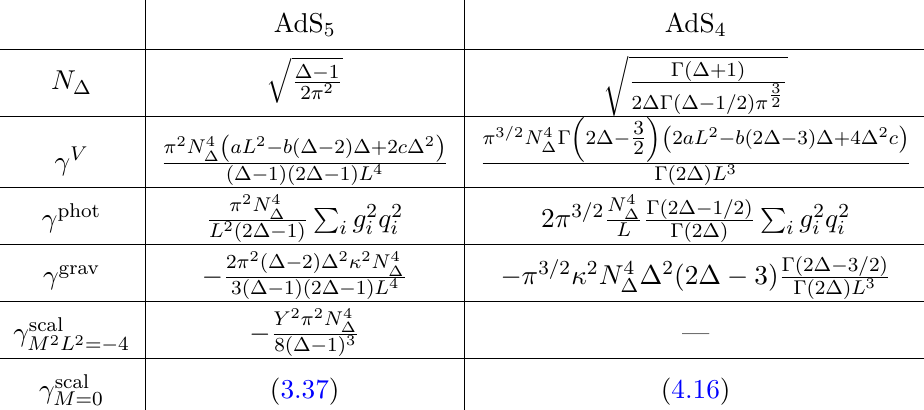
, for a special value 5 , which is ∆ < ∆ ≤ 3 4 2